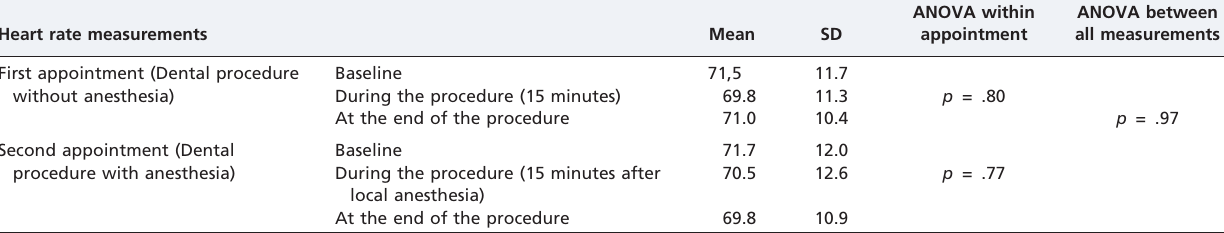
Table 4 - Mean, standard deviation (SD), and results of statistical analyses of six heart rate measurements taken during two different appointments for dental treatment with and without LAVA (2% mepivacaine with adrenaline 1100,000) (n=